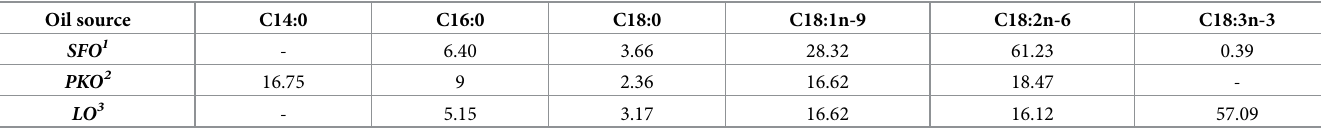
Table 2. The fatty acid (FA) contents (% of total identified FAs) of oil sources used to adjust the n -6: n